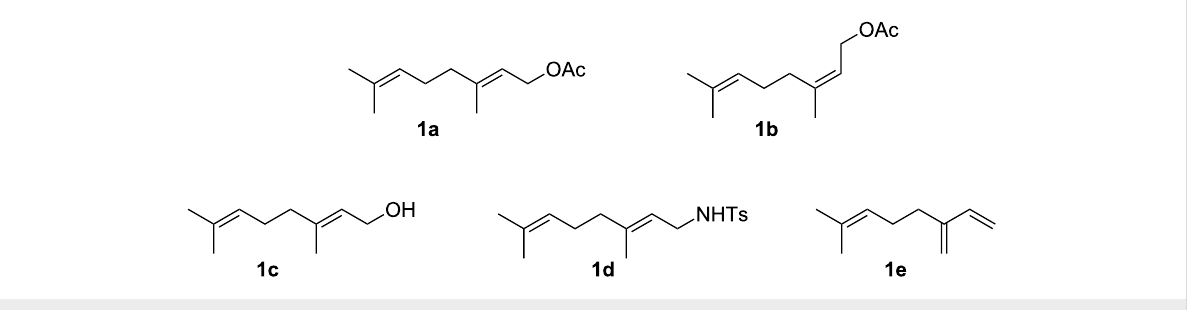
Figure 2: Selected monoterpenoids used in this study.